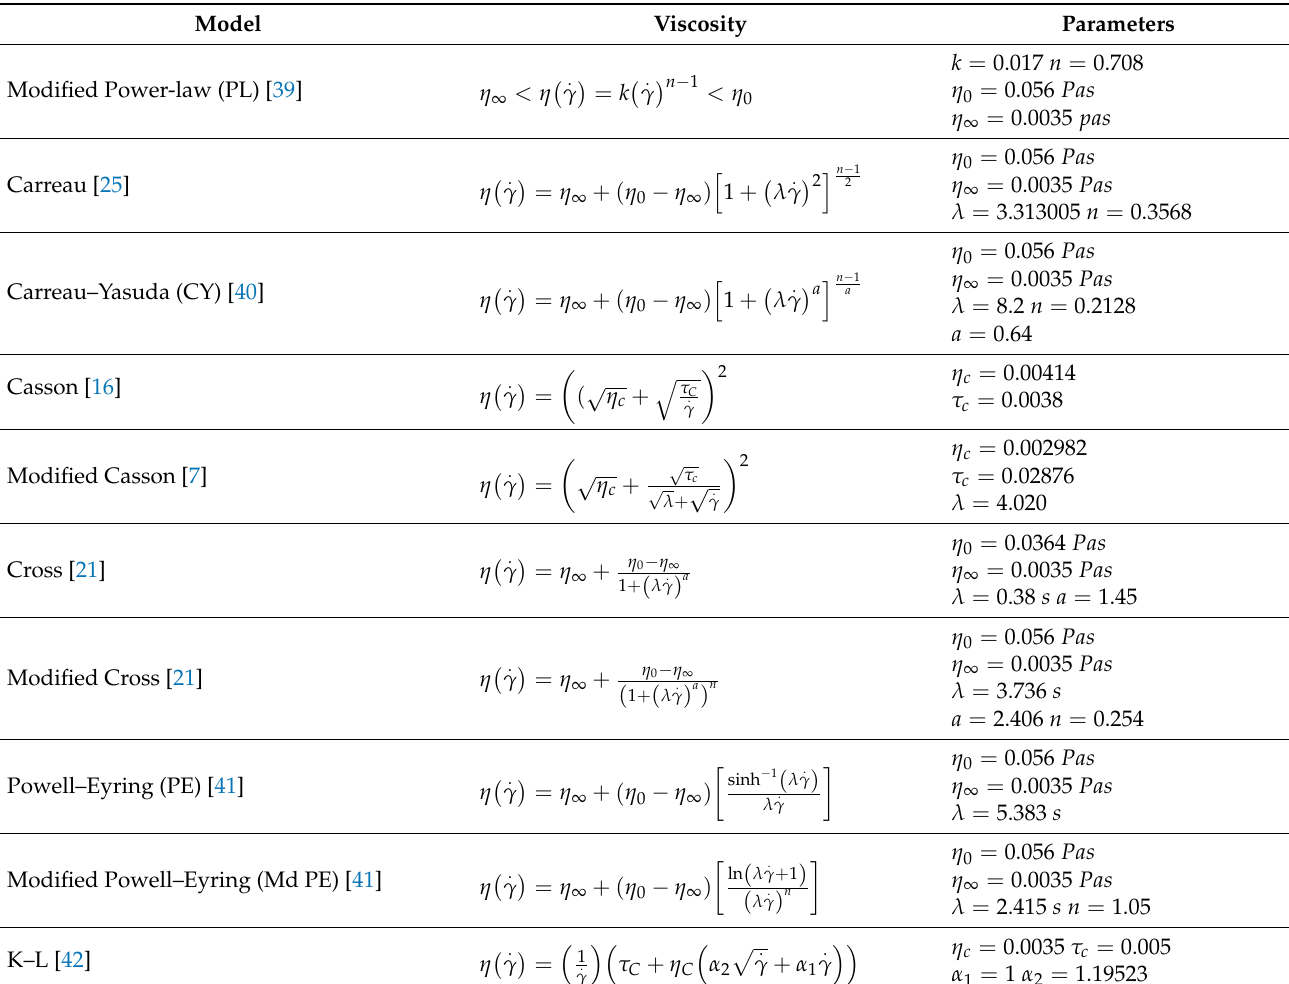
Table 1. Non-Newtonian viscosity models of blood